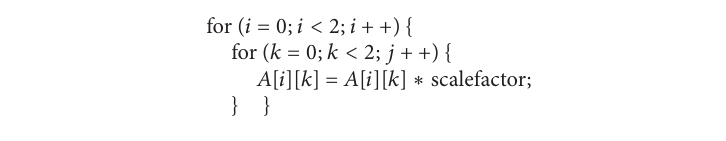
Algorithm 3: For-loop code for scaling a 2 × 2 matrix.